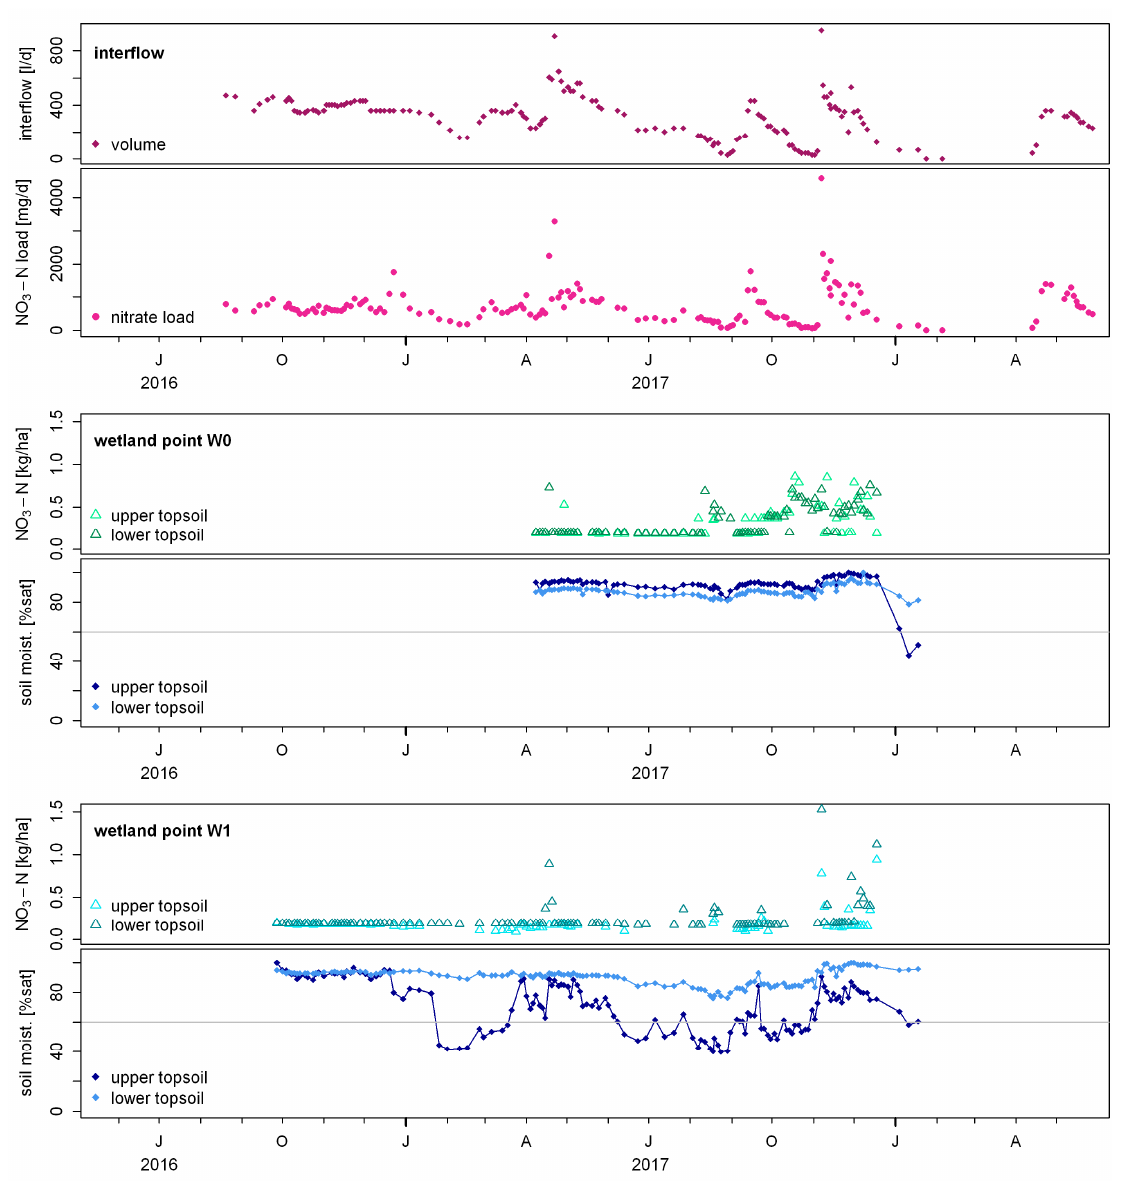
Figure 12. Interflow volumes and associated nitrate load at the plot under crop production (first panel) compared with the nitrate content in the soil solution and the soil moisture dynamics in the upper and lower topsoil of two measurement points in the wetland downslope of the plot under crop production (panels two and three). Timeline labeling “J A J O” refers to January, April, July, October.